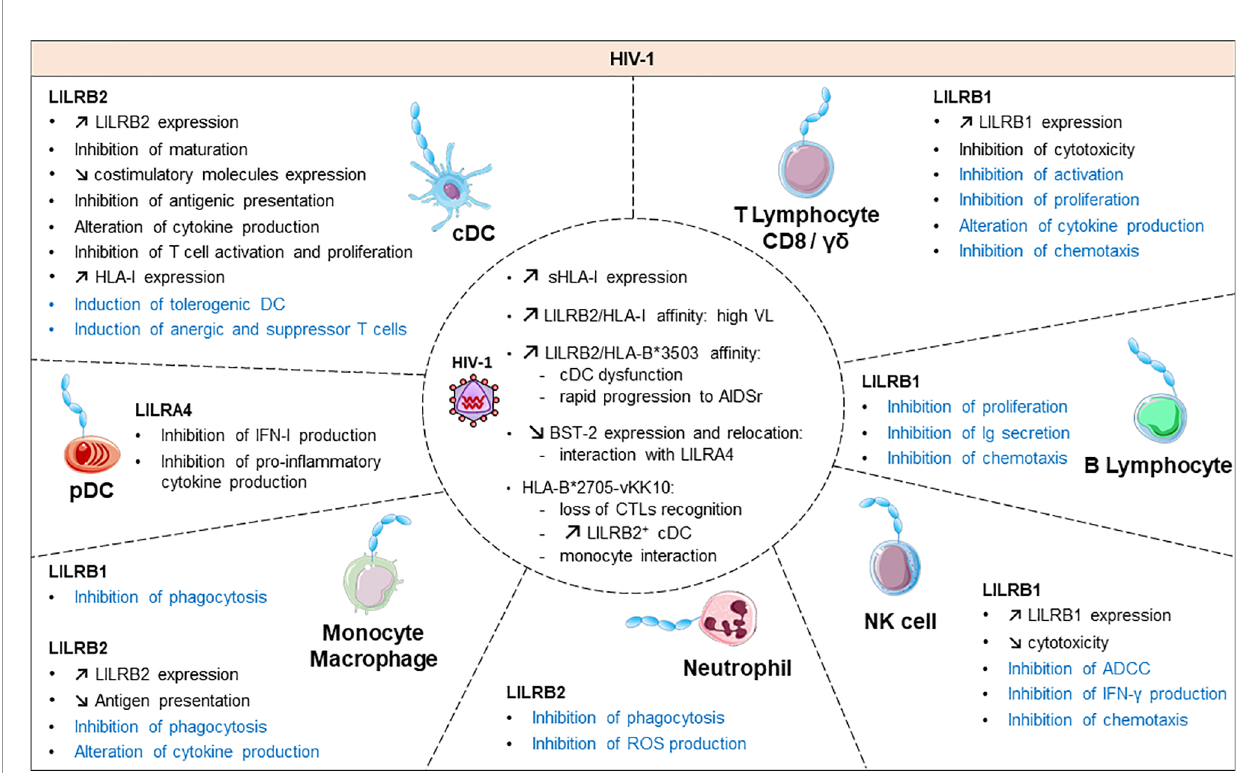
FIGURE 3 | Functional roles and dynamics of LILRs in HIV infection. HIV infection induces a dysregulation of the immune response. In black, the direct impact of HIV in conventional dendritic cells (cDCs), plasmacytoid dendritic cells (pDCs), monocytes/macrophages, natural killer (NK) cells, CD8 T cells and gd T cells are mentioned. The LILR-mediated dysregulation related to the upregulation of the HLA-I expression is shown in blue. ROS, reactive oxygen species; IFN- g , interferon g ; Ig, immunoglobulin; ADCC, antibody-dependent cellular cytotoxicity; CTL, cytolytic T